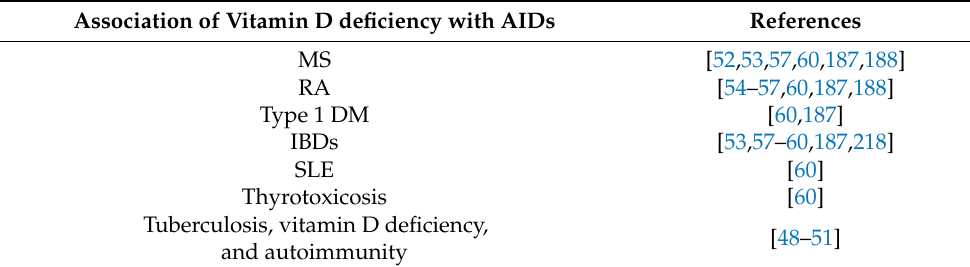
Table 2. Vitamin D deficiency and autoimmunity. Association of Vitamin D deficiency with